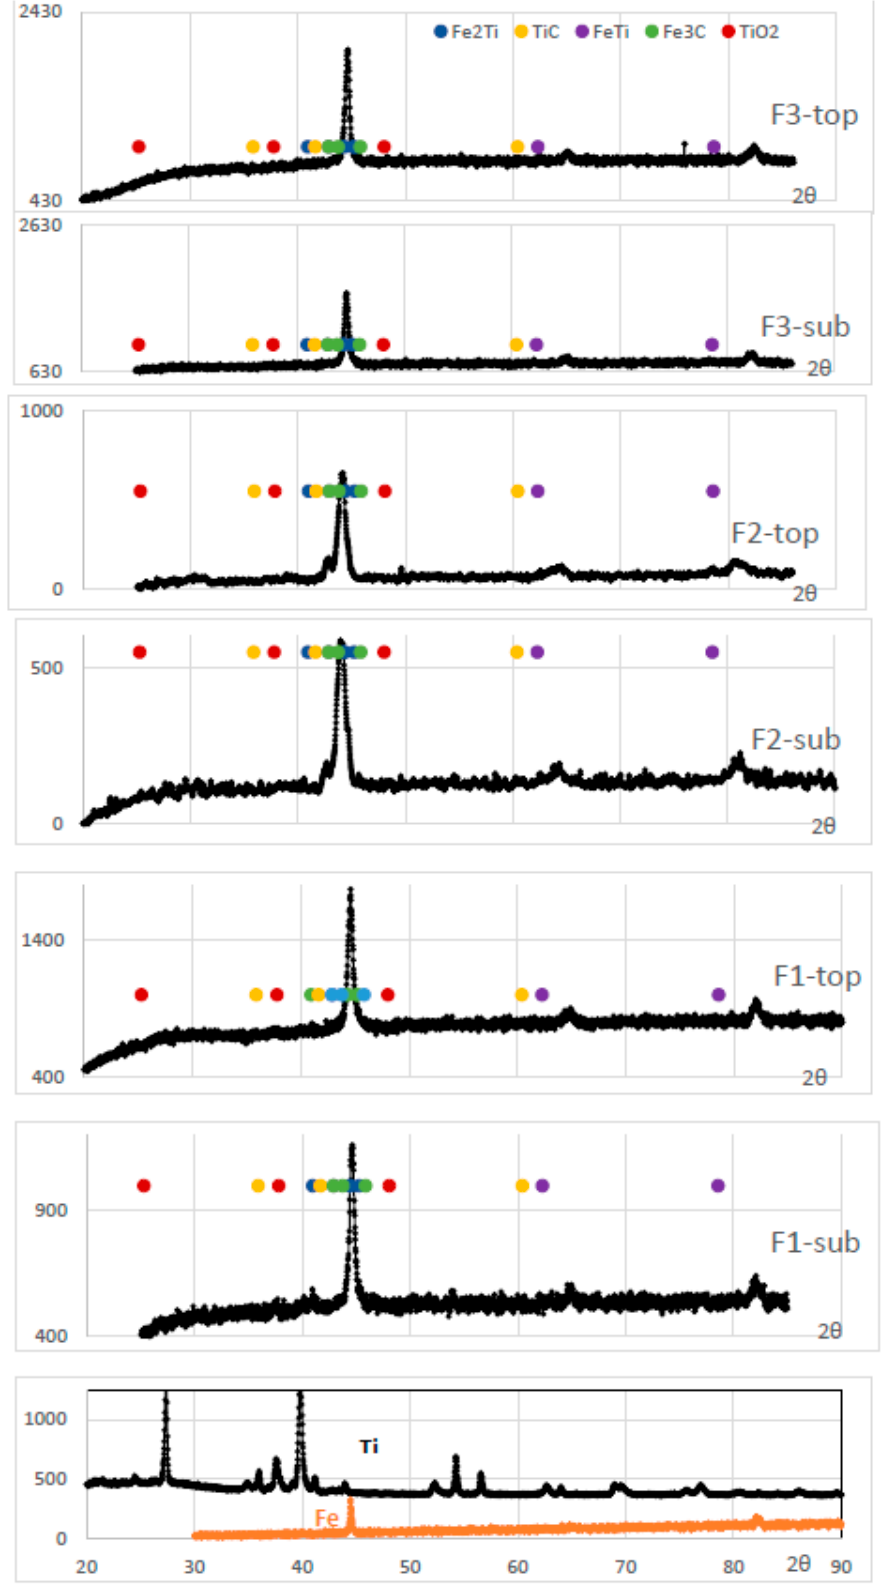
Figure 7. XRD patterns of the initial powders and final DED of a Ti-Fe-graded multilayer sample produced by all regimes.